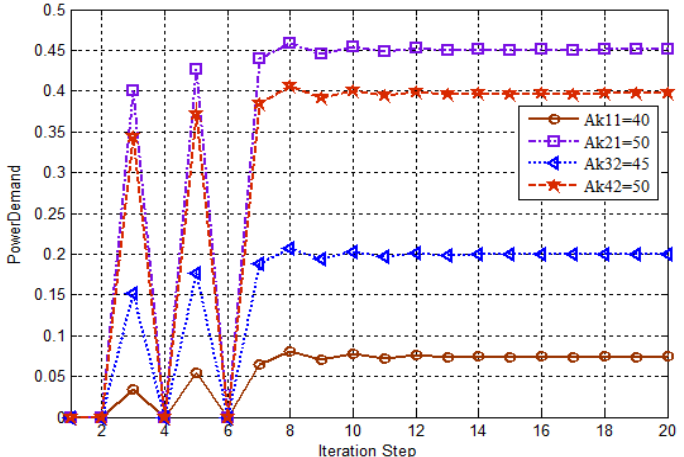
Figure 7. CSOs’ power demand brought from CSOs compared with the iteration step, in which ζ 1 = 0.05 and ζ 2 = 0.01, and its initial price p i = 10 $/MW · h, W m 1 = 0.3 h, W m 2 = 0.4 h,